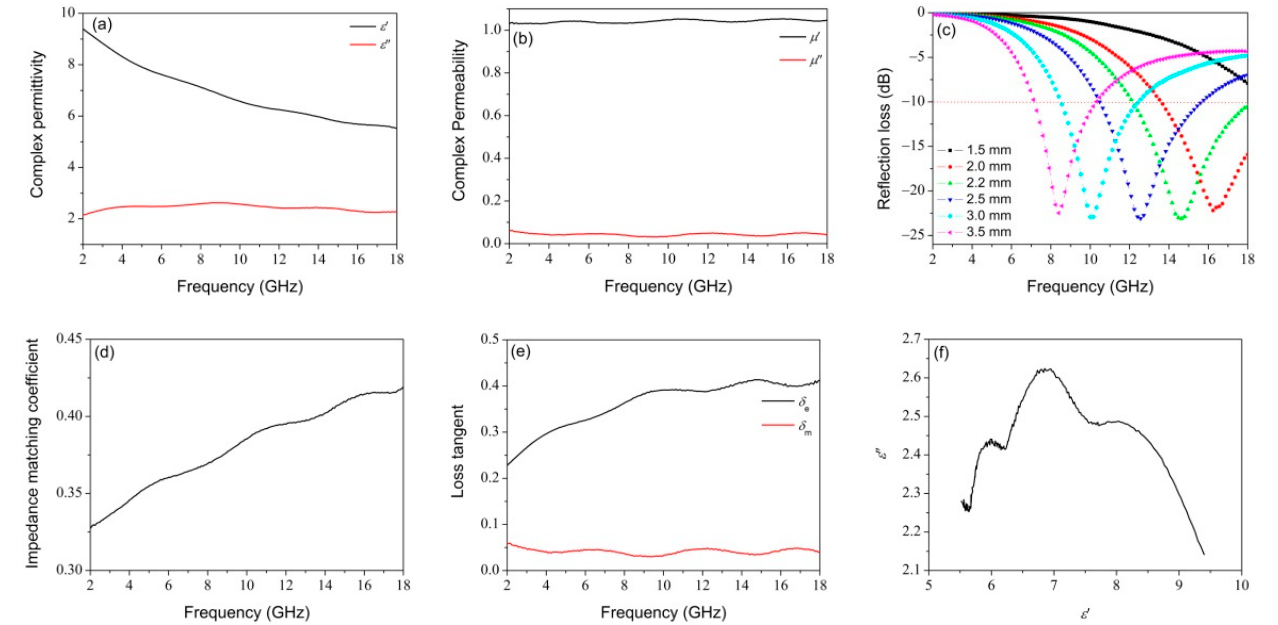
Figure 11. The frequency dependence of ( a ) complex permittivity, ( b ) complex permeability, ( c ) simulated reflection loss, ( d ) impedance matching coefficient, ( e ) loss factor, and ( f ) Cole–Cole curve of NiFe 2 O 4 /carbonized hemp fibers.